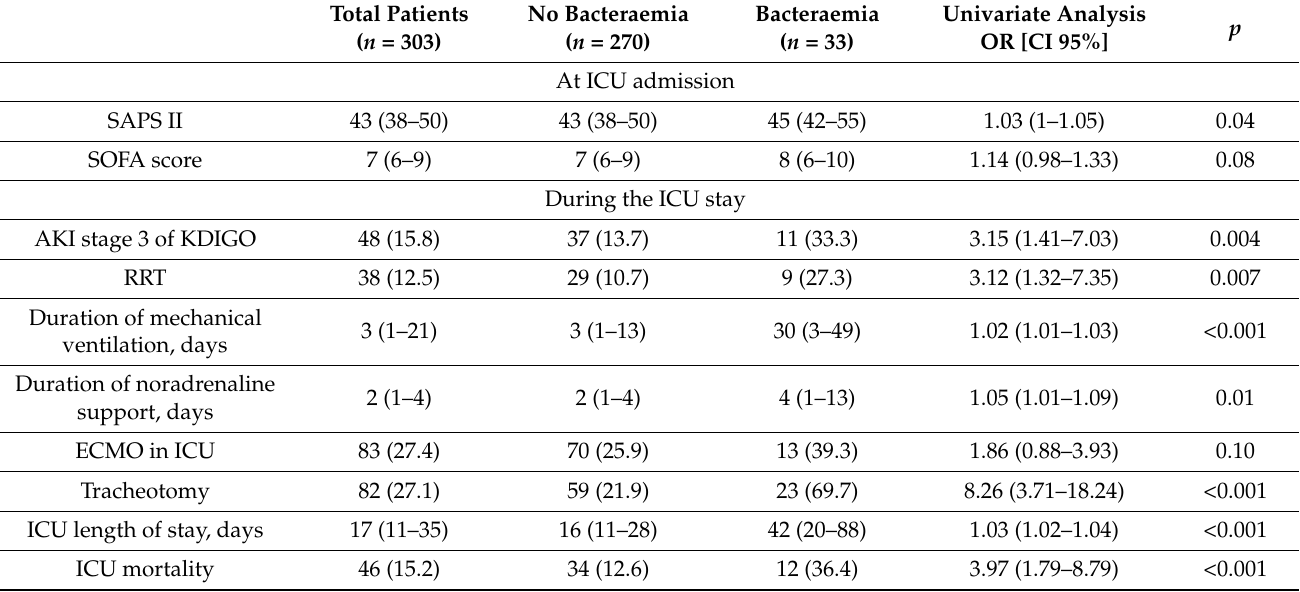
Table 3. Comparison of morbidity and mortality during the posttransplant ICU stay between patients with and without